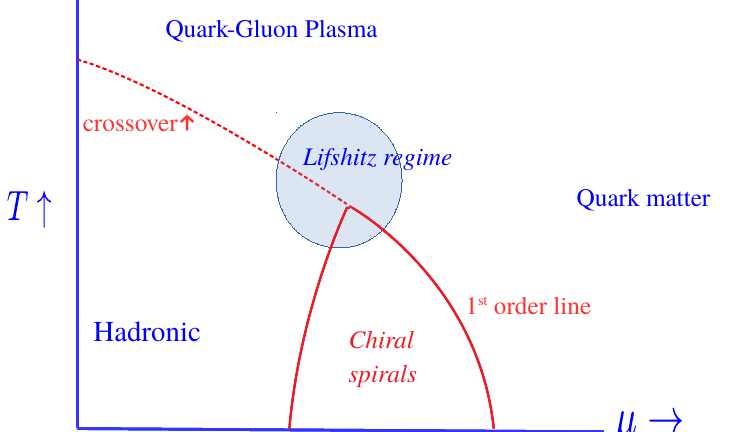
Figure 6. A proposed phase diagram for quantum chromodynamics (QCD) in the plane to temperature T and chemical potential µ . We assume that the critical endpoint lies in the region of spatially inhomogeneous phases or chiral spirals. There is an unbroken line of first-order transitions which encloses the regime with chiral